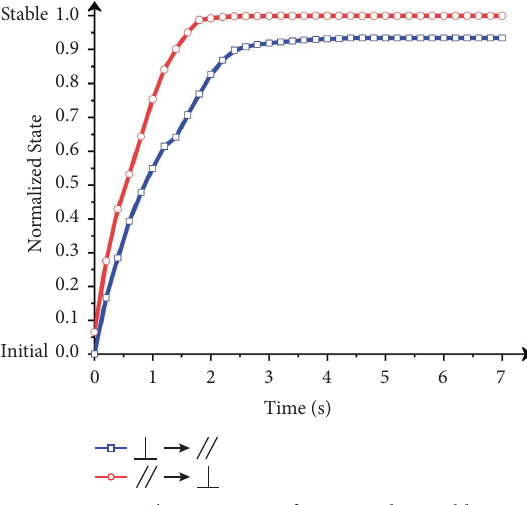
Figure 9: Te state curve from initial to stable.